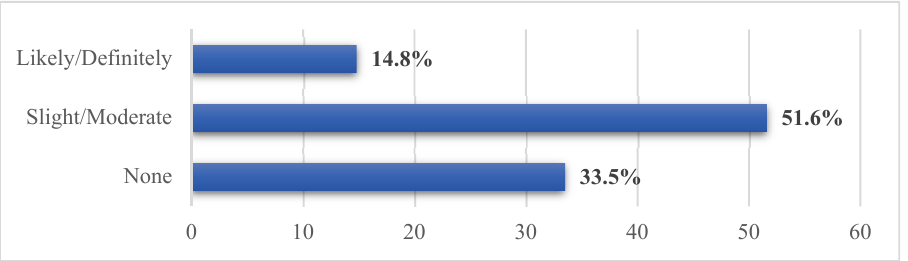
Figure 2. Participants’ perception regarding burnout they experience from the use of EHR and its associated features due to the COVID-19 pandemic.